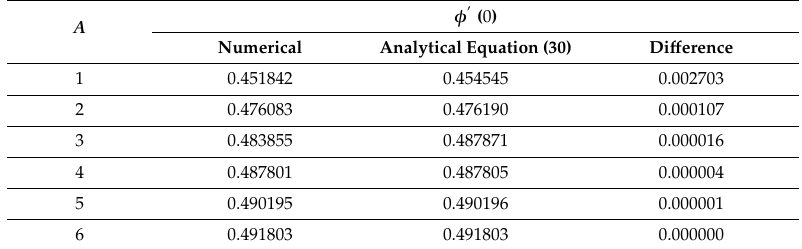
Table 2. Comparison of numerical results for φ (cid:48) ( 0 ) and analytical Equation (30) for a variety of suction-strength parameters when Sc = 5 and K s = 0.5.